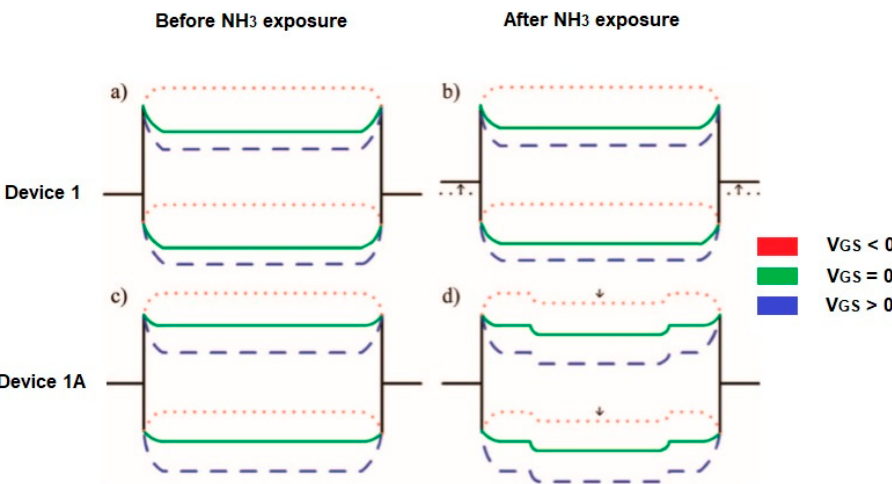
Figure 7. Scheme of the energy band diagram for device 1 ( a ) before and ( b ) after exposure on NH 3 . An intrinsic CNT is considered (the work function of the source / drain electrodes is initially near the valence band edge of the CNT) and for device 1A (the contacts passivated by Si 3 N 4 , the work function of electrodes aligns near the midgap of CNT. The Fermi level of the CNT channel shifts upwards due to electron-doping from NH 3 ) ( c ) before and ( d ) after exposure to NH 3 . V GS - gate voltage. Partially reprinted with the authors' permission [30].